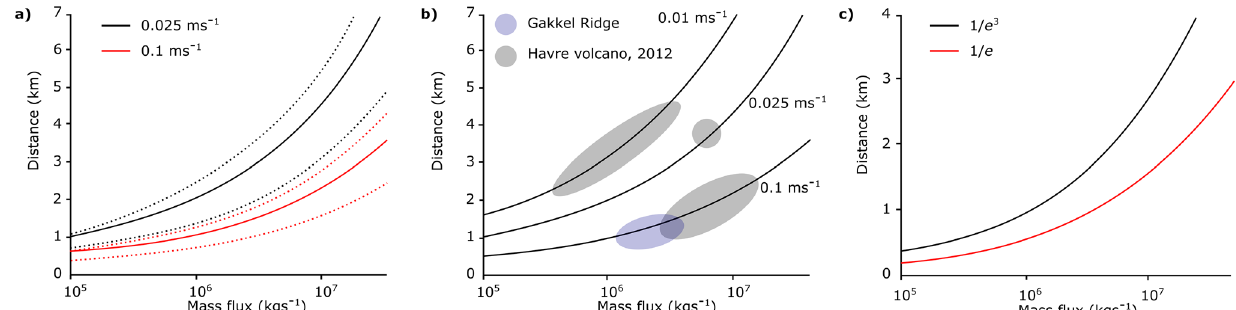
Figure 5. ( a ) Estimate of the range of particle dispersal distances of the fall deposit as a function of the mass eruption rate for particles with fall speed 0.025 and 0.1ms − 1 . Curves are shown for the cases in which 0.75 (upper curve ), 0.5 (middle curve ) and 0.25 (lower curve) of the fluid in the fountain separates and rises up to form the plume; in each case it is assumed that a fraction 0.1 of the particle load in the fluid also rises up in the plume. ( b ) Estimate of the range of particle dispersal distances of the fall deposit as a function of the mass eruption rate, for particles of fall speed 0.1, 0.025 and 0.01ms − 1 , in the case that a fraction 0.5 of the fluid separates from the fountain. The circles illustrate the range of dispersal distances for sediment of particular fall speeds in Havre 2012 eruption deposit (grey circles) and the Gakkel ridge deposits (blue ellipse). ( c ) Estimate of the radial transport distance of particles in a radially spreading submarine flow. Curves correspond to the distance at which the particle load has decreased by a factor 1/ e (red line) and 1 / e 3 (black line), for a particle with settling speed of 0.01ms − 1 Here V w is the volume flux in the collapsing fountain and h is the thickness of the pyroclastic flow. Using our estimates for the volume flux in the fountain, as calculated from our near-source fountain model, in Fig. 5c we present an estimate for the length scale R , over which the concentration of particles, C , and hence the deposition rate, has decreased by a factor 1/ e of the initial value in the pyroclastic flow